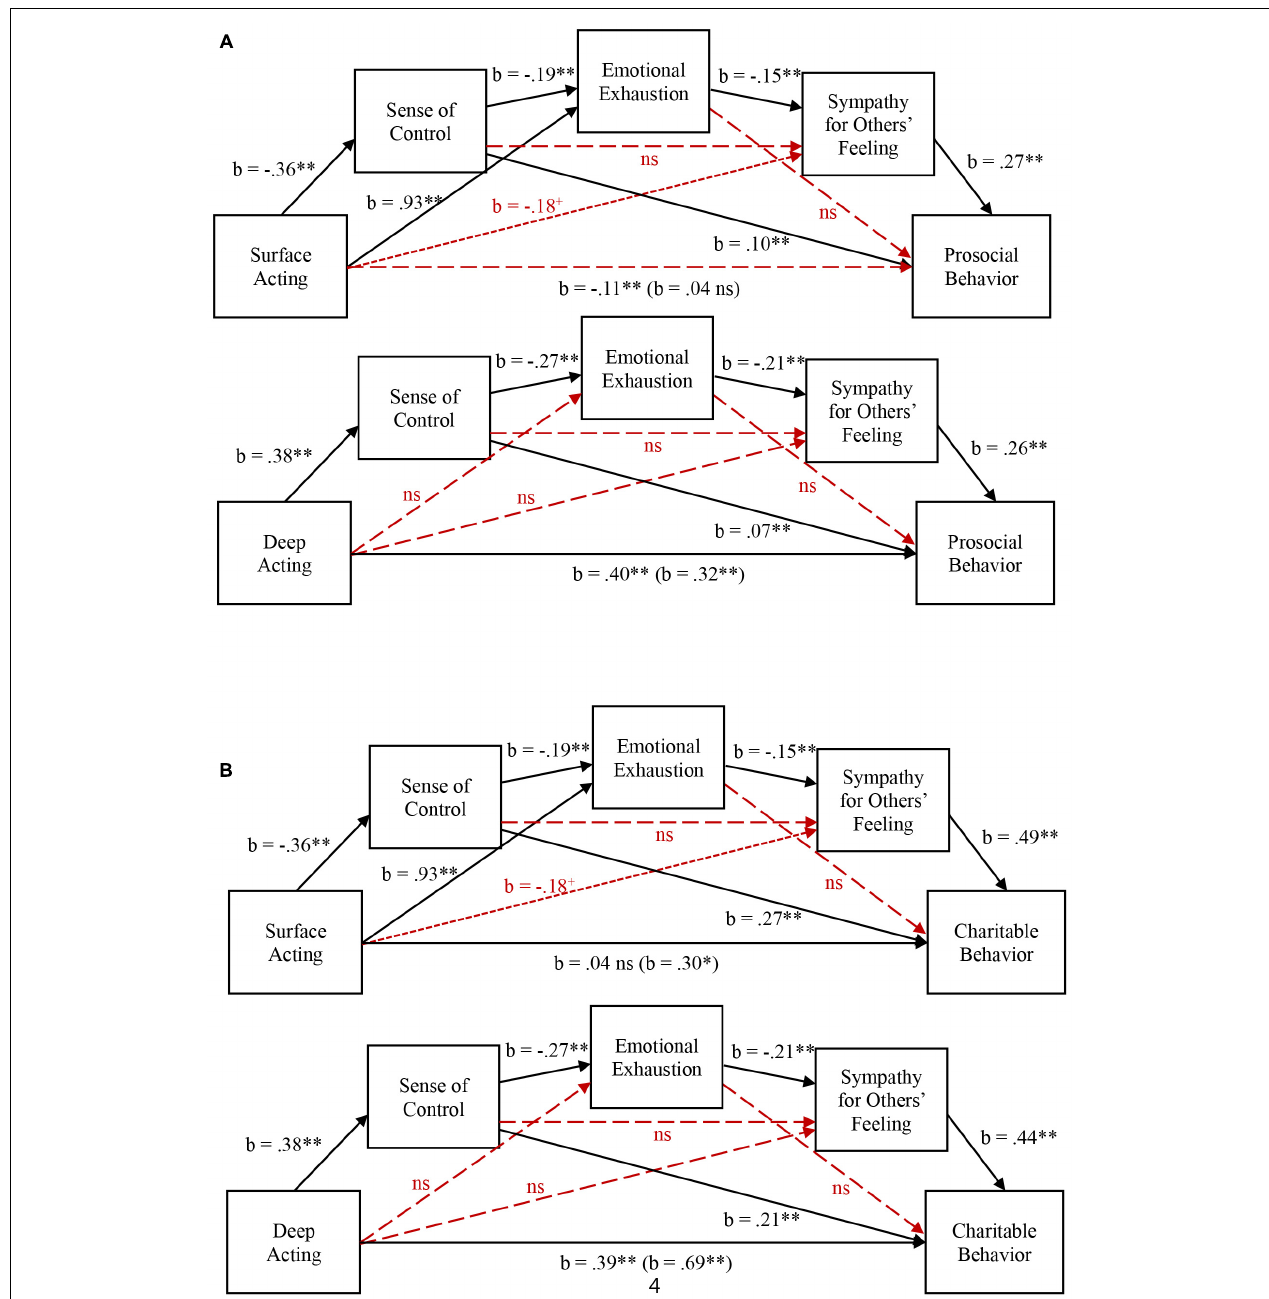
FIGURE 2 | Serial mediational analyses for Study 3. (A) The effect of display rules on prosocial behavior. (B) The effect of display rules on charitable behavior. + p < 0.10, ∗ p < 0.05, ∗∗ p <